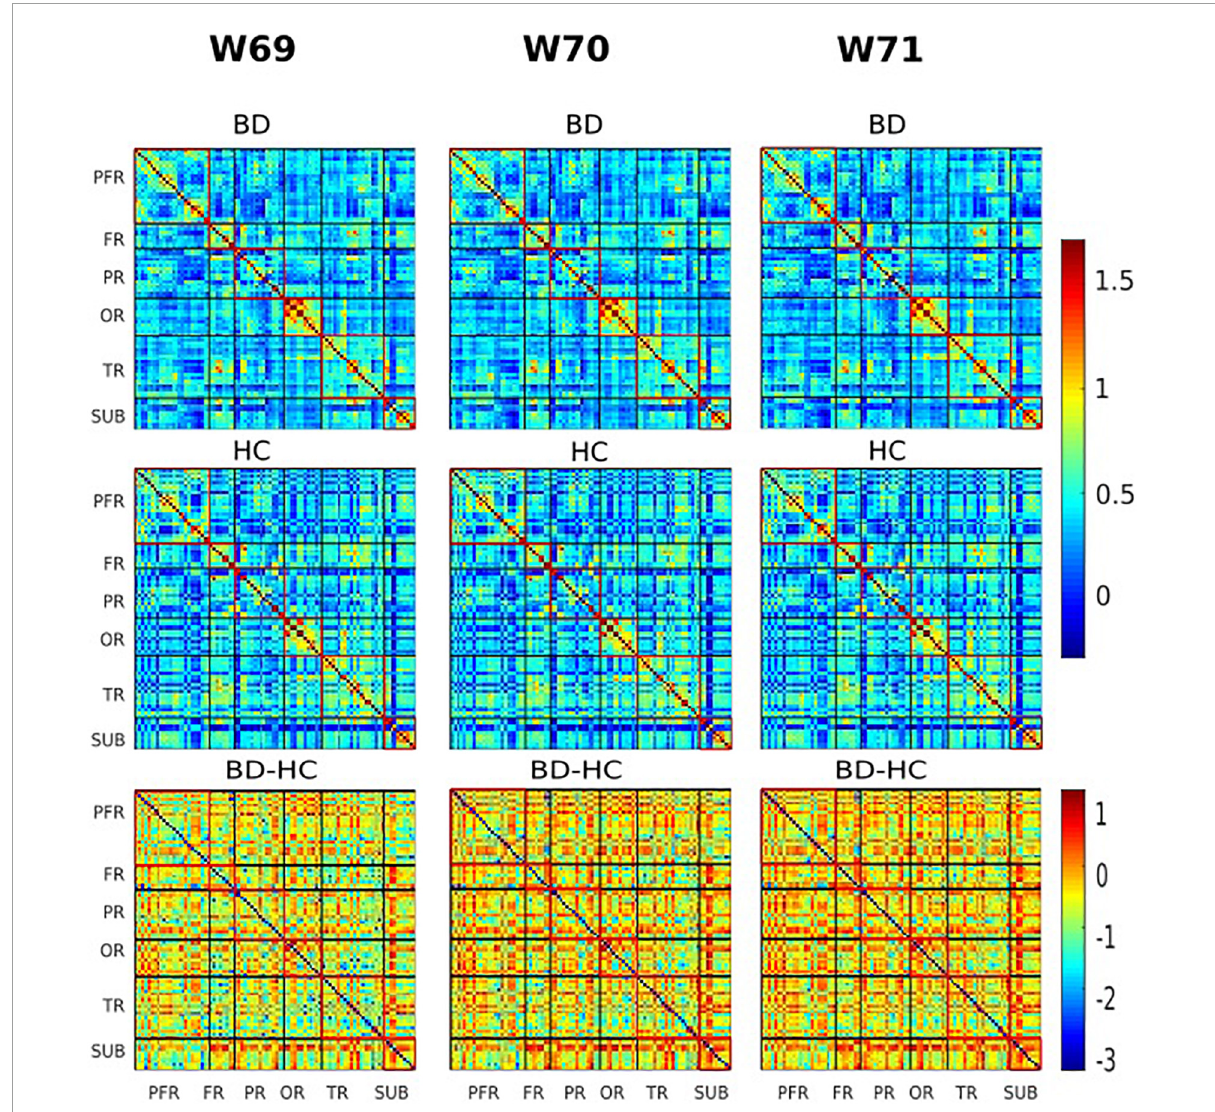
FIGURE5 The group variability maps at windows 69, 70, and 71 (180, 182, and 184 s). Where BD-HC is the group difference that survived the thresholding, values are plotted as –log10 ( p -value) × sign ( t -statistic). The lines partition the rsFC maps into six subcategories (i.e., PFR, prefrontal; FR, other frontal; PR, parietal; OR, occipital; TR, temporal; SUB, subcortical regions). Color bars represent correlation ( z